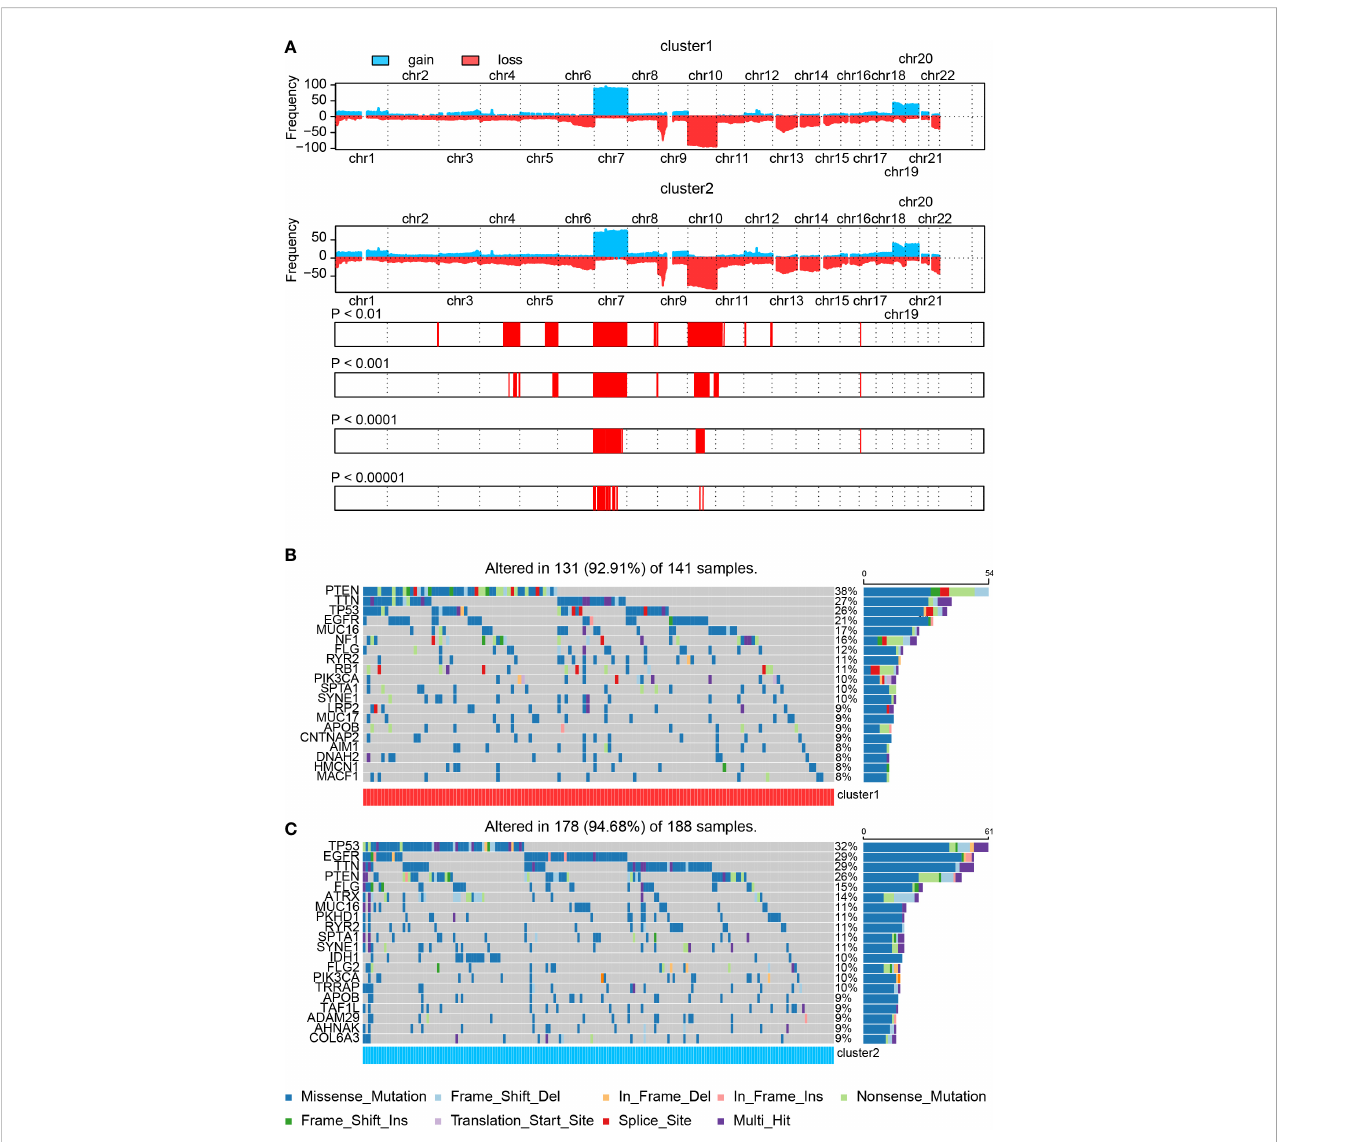
FIGURE 3 The SNP and CNV difference in the cluster model. (A) CNV difference in the cluster model. (B, C) SNP difference in the cluster